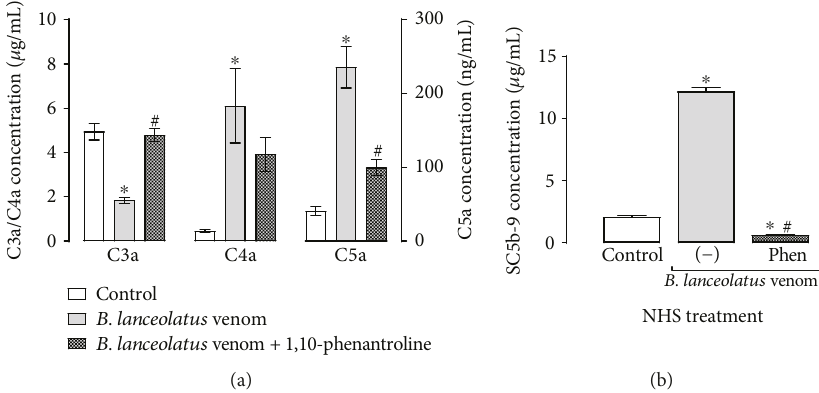
Figure 2: Production of Complement activation products in NHS incubated with B. lanceolatus venom. NHS (diluted 1 :2 in saline solution) was incubated with B. lanceolatus venom (0.5 mg/mL) for 30 min at 37 ° C, in the presence or absence of 1,10-phenantroline (10 mM). As control, NHS was incubated with saline solution. (a) Samples were diluted 1 :5000 and the concentrations of the anaphylatoxins C3a/C3a- desArg, C4a/C4a-desArg, and C5a/C5a-desArg were determined using a cytometric bead array. (b) Samples were diluted 1:150, and the concentration of the SC5b-9 complex was measured by “ MicroVue SC5b-9 Plus EIA Kit ” . The data represent two experiments, realized in duplicate. ∗ p < 0 05 compared to the saline-treated NHS controls. # p < 0 05 compared to venom-treated